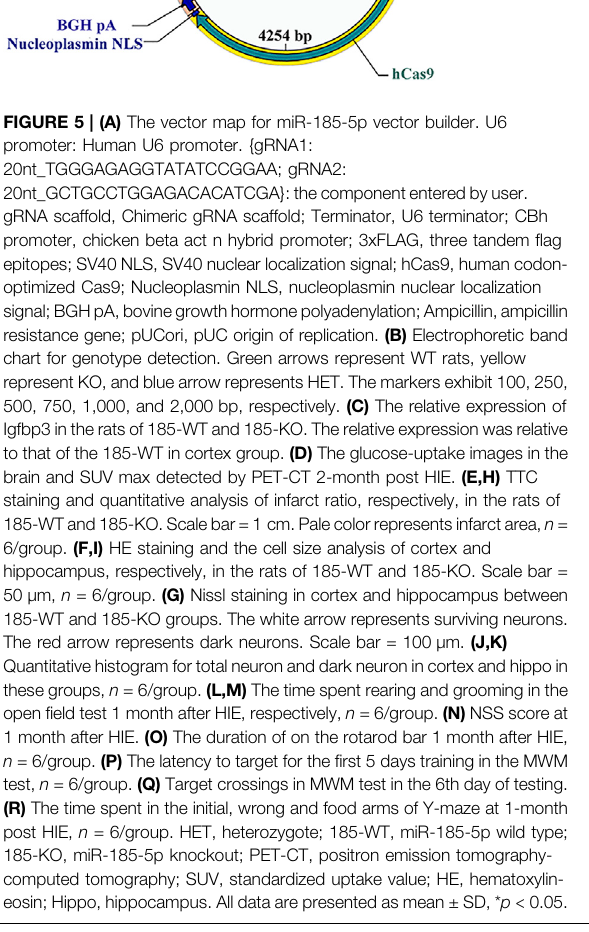
Frontiers in Cell and Developmental Biology |